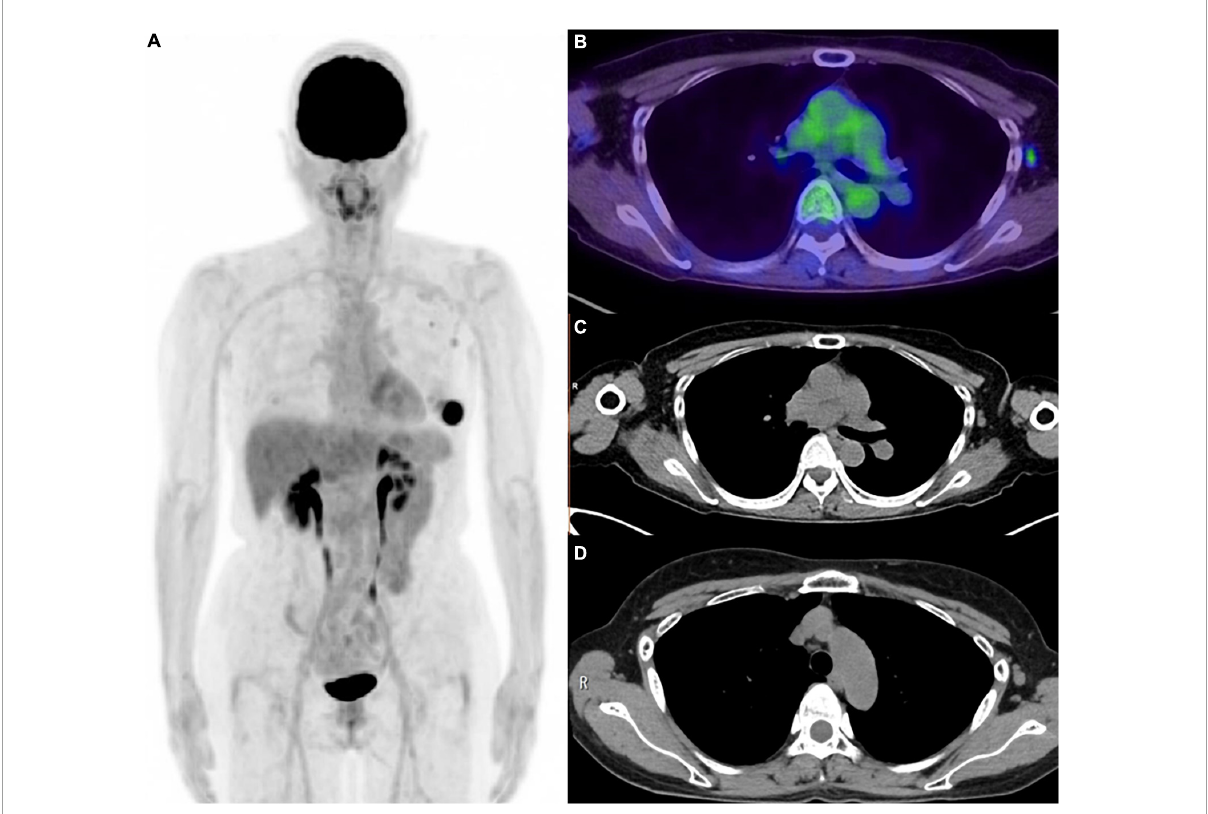
FIGURE3 Six weeks after the COVID-19 vaccination for the patient with left breast cancer. (A) MIP image of FDG PET, (B) axial image of PET/CT, (C) CT portion of PET/CT, (D) CT image (2 weeks after the vaccination). Weak FDG uptakes were confirmed in the small axial lymph node and subclavian lymph node. These lymph node was pathologically diagnosed as lymph node metastasis from left breast cancer. Axial lymph node in CT image obtained 2 weeks after the vaccination was slightly larger than those in the PET/CT image, which might be the effect of